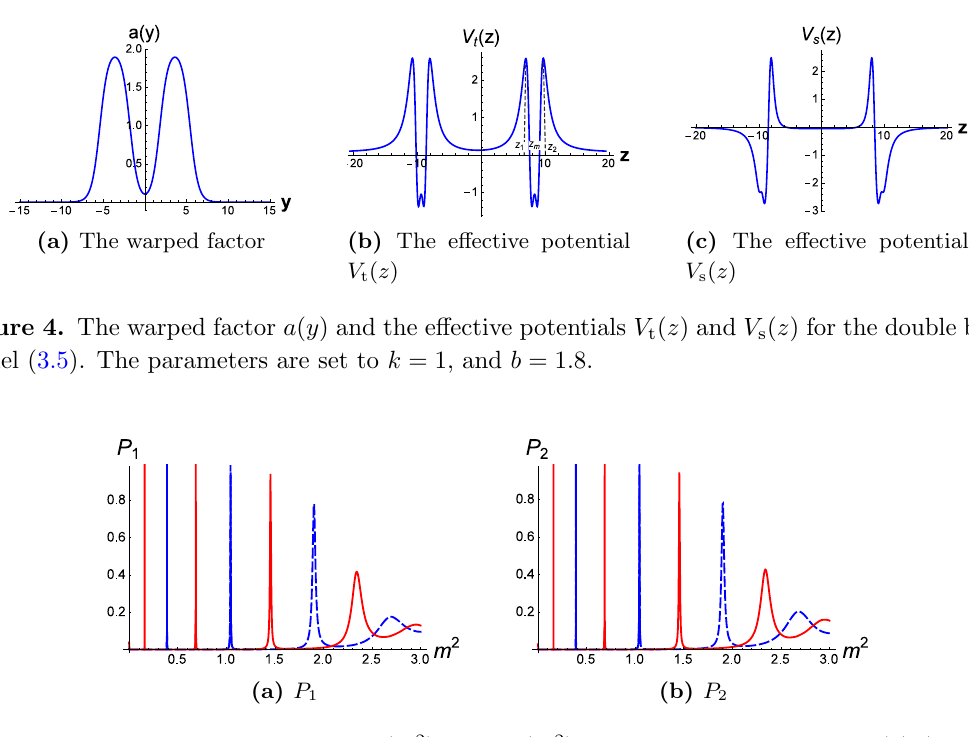
Figure 5. The relative probability P 1 ( m 2 ) and P 2 ( m 2 ) of the even parity mode t e ( z ) (red solid lines) and the odd parity mode t o ( z ) (blue dashed lines) for the double brane model (3.5). The parameters are set to k = 1 and b = 1 :